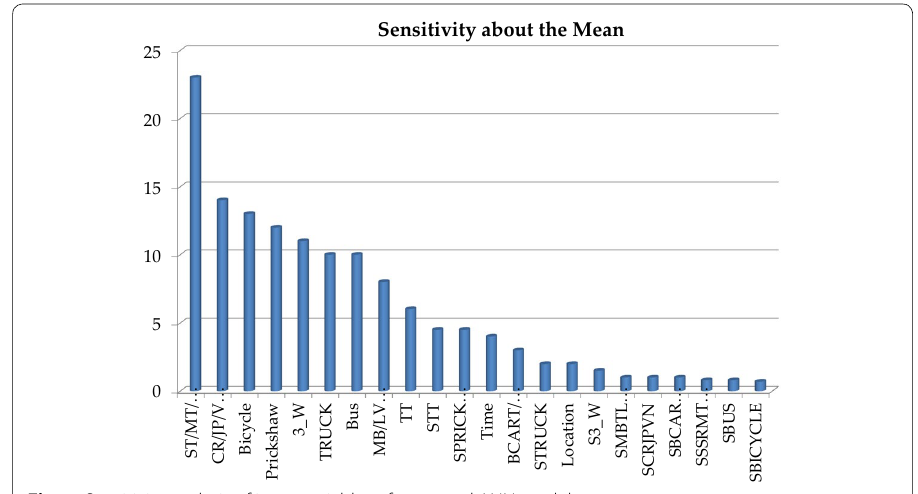
Fig. 4 Sensitivity analysis of input variables of proposed ANN model